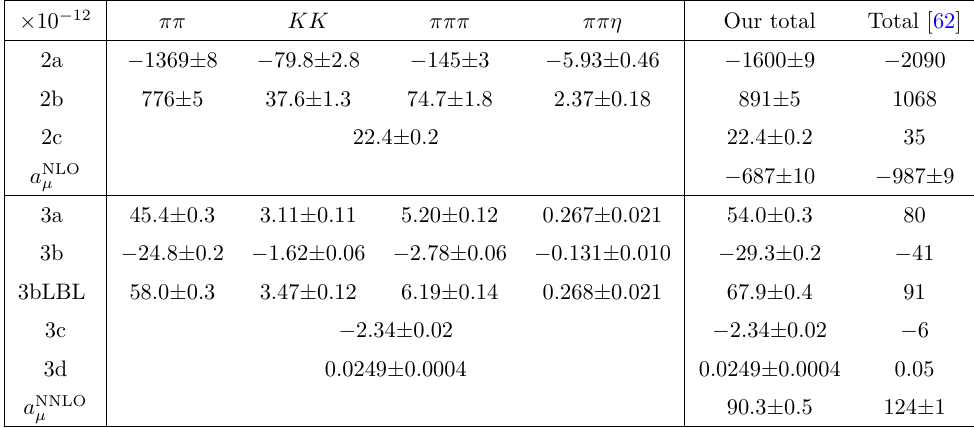
using Fit II results µ